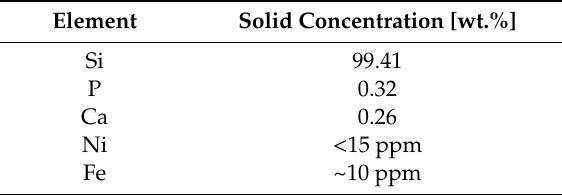
Table 2. Chemical composition of SiC F400 powder.